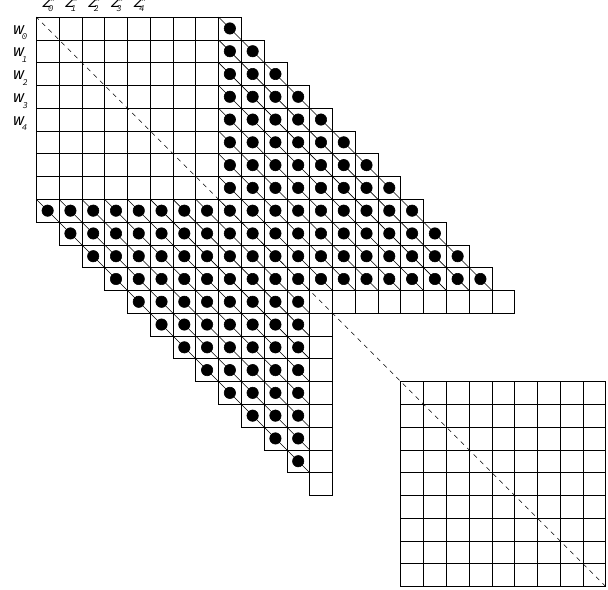
Fig. 3. A small cross-lag profile matrix (XLPM) with eight non- zero lags in either direction. The points used for estimating the cross-correlation function (XCF) for a single range are marked; four lag zero points are used here. The points along each diagonal are averaged to form the estimate of the cross-correlation at that lag